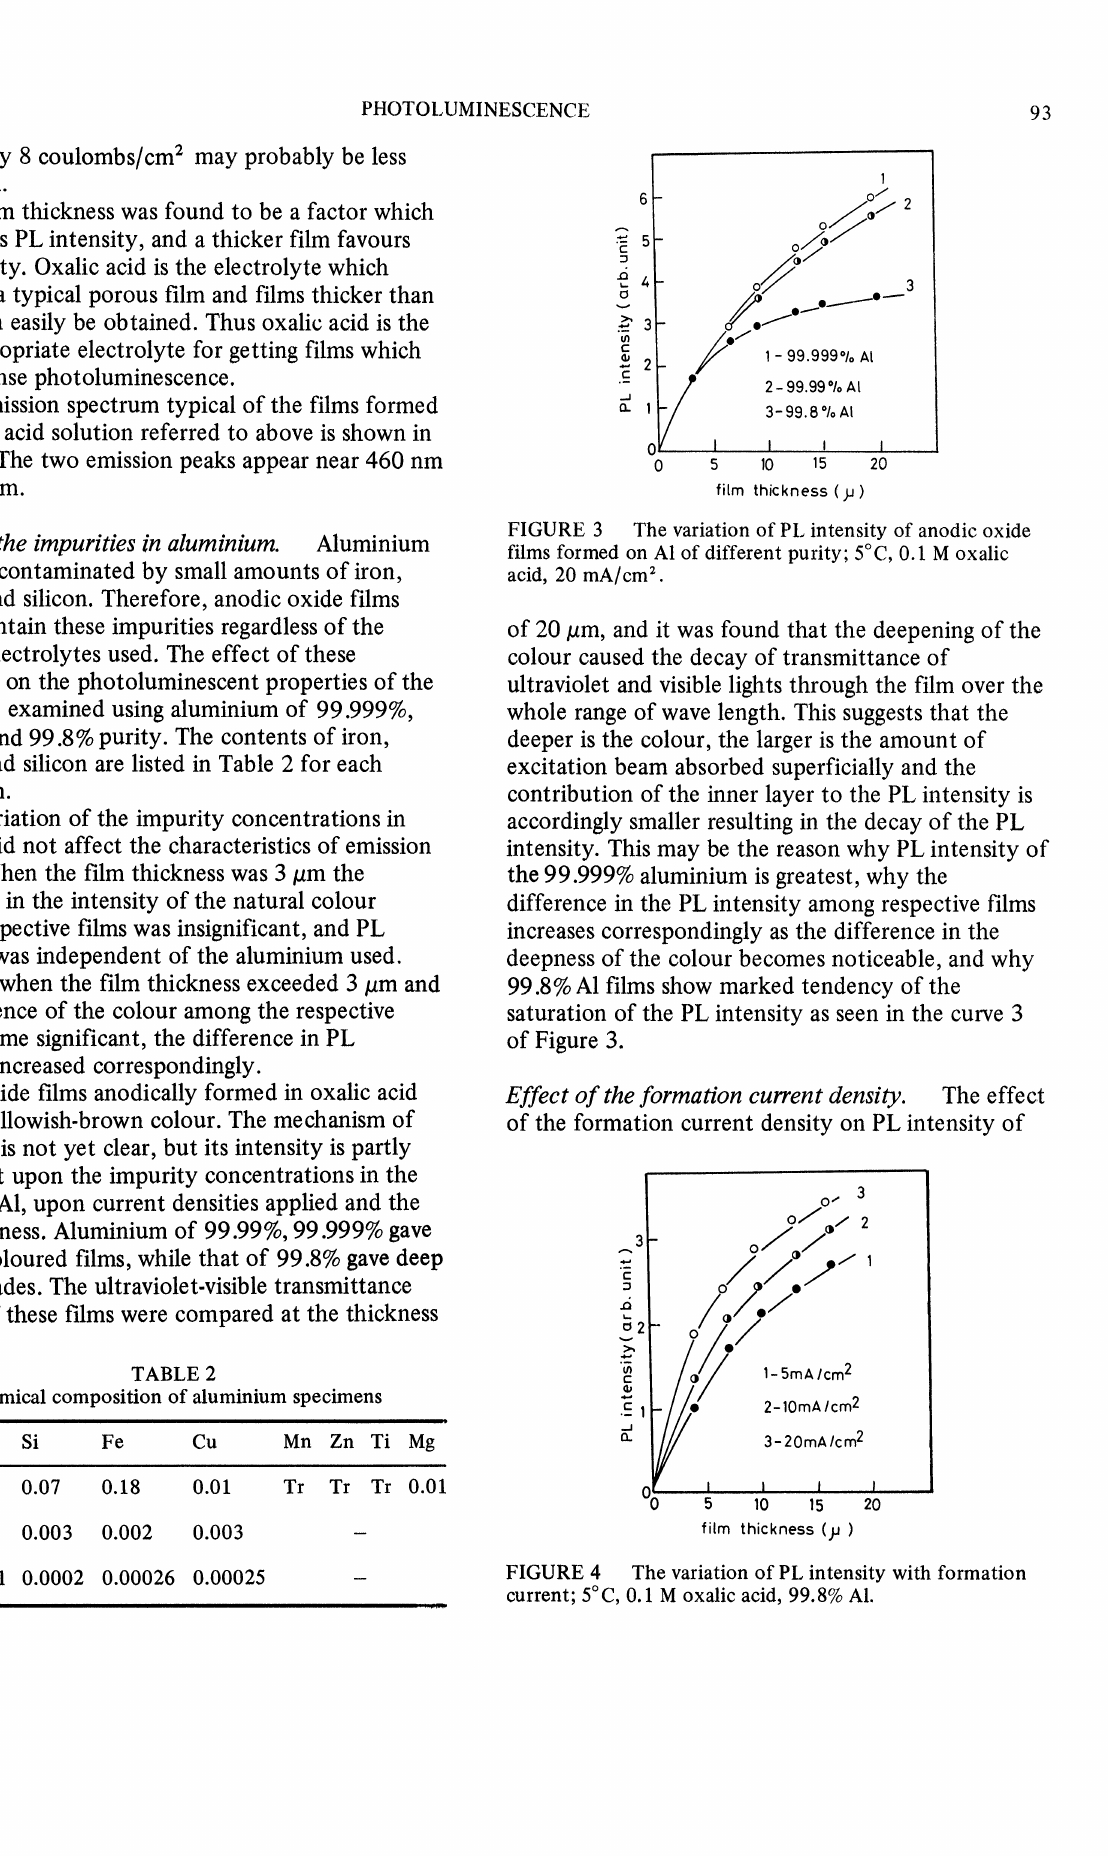
The variation of PL intensity with formation current; 5 C, 0.1 M oxalic acid, 99.8%